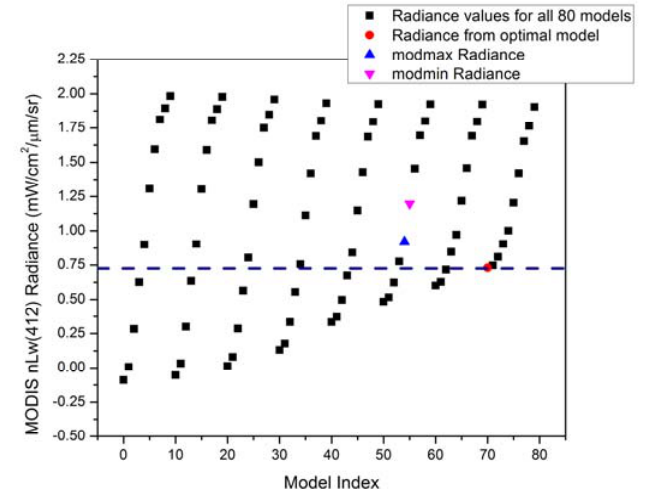
Figure 9. MODIS retrieved L (412) for all 80 aerosol models at the AERONET-OC n w location, Martha’s Vineyard, 25 July 2010. Also indicated are the radiance values corresponding to the modmin, modmax, and optimal models; the dashed line indicates the in situ value